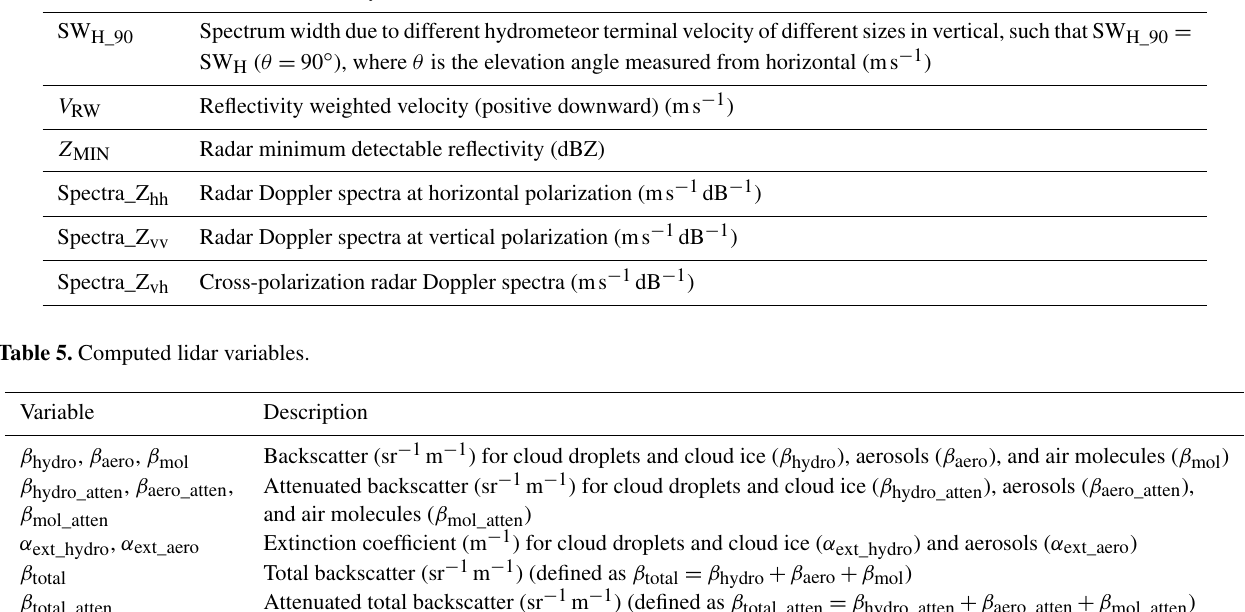
Table 4. Computed radar variables. Units of the variables stored in the output files are provided in parenthesis. Variable Description Z hh Radar reflectivity factor at horizontal polarization (dBZ) Z vv Radar reflectivity factor at vertical polarization (dBZ) Z vh Cross-polarization radar reflectivity factor (dBZ) Z DR Differential reflectivity, defined as the ratio between the fraction of horizontally polarized backscattering and vertically polarized backscattering (dB) LDR h Linear depolarization ratio, defined as the ratio of the power backscattered at vertical polarization to the power backscattered at horizontal polarization for a horizontally polarized field (dB) K DP Specific differential phase, defined as the backward propagation phase difference between the horizontally and vertically polarized waves at a specific distance ( ◦ km − 1 ) δ Differential backscatter phase, defined as the difference between the phases of horizontally and vertical po- larized components of the wave caused by backscattering from the objects in the radar resolution volume, computed based on Trömel et al. (2013) ( ◦ ) A h Specific attenuation at horizontal polarization, or, for horizontally polarized waves, represented by forward scattering amplitudes (dBkm − 1 ) A v Specific attenuation at vertical polarization, or, for vertically polarized waves, represented by forward scattering amplitudes (dBkm − 1 ) A DP Specific differential attenuation, defined as the difference between the specific attenuations for horizontally and vertically polarized waves (dBkm − 1 ) V D Mean radial Doppler velocity (positive away from the radar) (ms − 1 ) V D_90 Mean vertical Doppler velocity (positive upward) (ms − 1 ) SW TOT Spectrum width, including contribution of four major spectral broadening mechanisms (Doviak and Zrni´c, 2006): (1) different hydrometeor terminal velocities of different sizes SW H , (2) turbulence, (3) mean wind shear contribution, and (4) cross-wind contribution. Antenna motion and contributions due to variation of orientation and vibrations of hydrometeor are not considered. (ms − 1 ) SW H_90 Spectrum width due to different hydrometeor terminal velocity of different sizes in vertical, such that SW H_90 = SW H ( θ = 90 ◦ ), where θ is the elevation angle measured from horizontal (ms − 1 ) V RW Reflectivity weighted velocity (positive downward) (ms − 1 ) Z MIN Radar minimum detectable reflectivity (dBZ) Spectra_Z hh